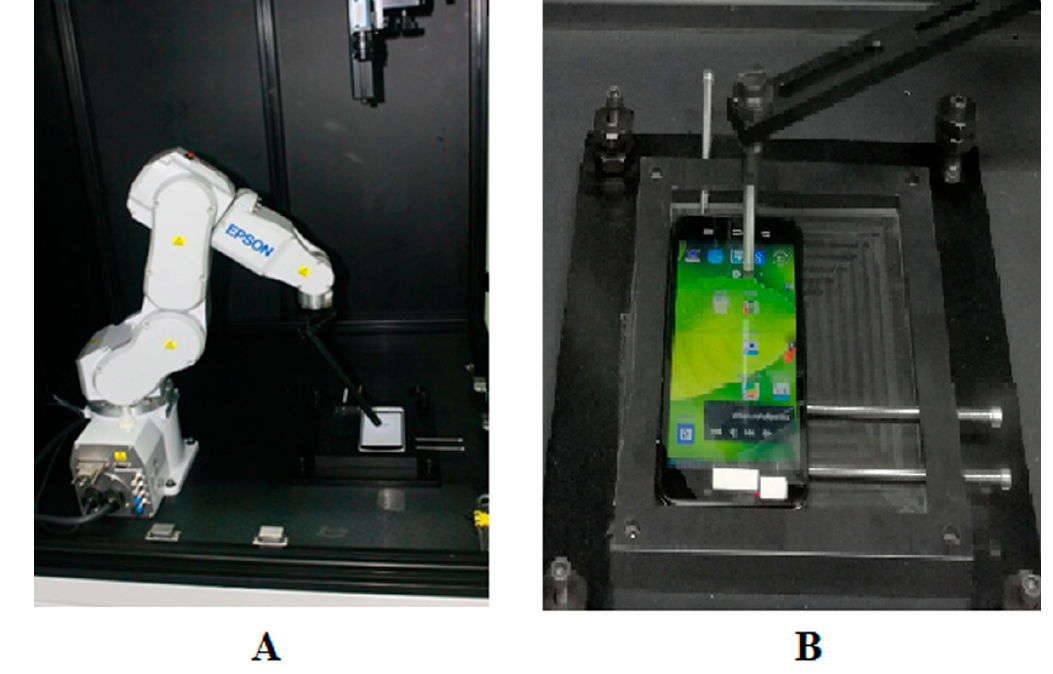
Figure 1. System. ( A ) Robotic arm with high-speed camera. ( B ) Interaction of the pointer with the mobile device.